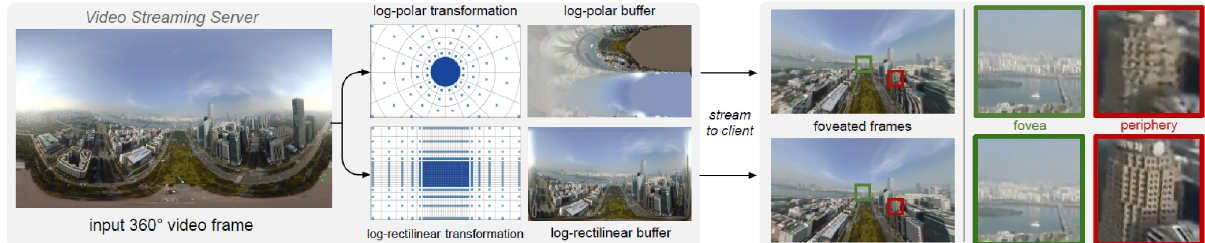
Fig. 13 Log-rectilinear transformation for foveated 360 ◦ video streaming proposed by Li et al. [151]. The upper and lower rows present the workflows with prior log-polar transformation and the proposed log-rectilinear transformation respectively. Both foveated methods convert the equirectangular video frames into down-sampled buffers, and subsequently encode and stream buffers to the client. On the client side, buffers are decoded to the screen space to generate the final results. The log-rectilinear transformation reduces flickering and aliasing artifacts in both the foveal and peripheral regions more significantly than that of the prior log-polar transformation. Reproduced with permission from Ref. [151], c (cid:13) IEEE